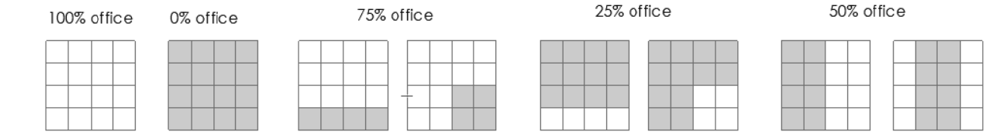
Figure 4. The 8 BGs examined: office and atrium possible proportions within the BG.